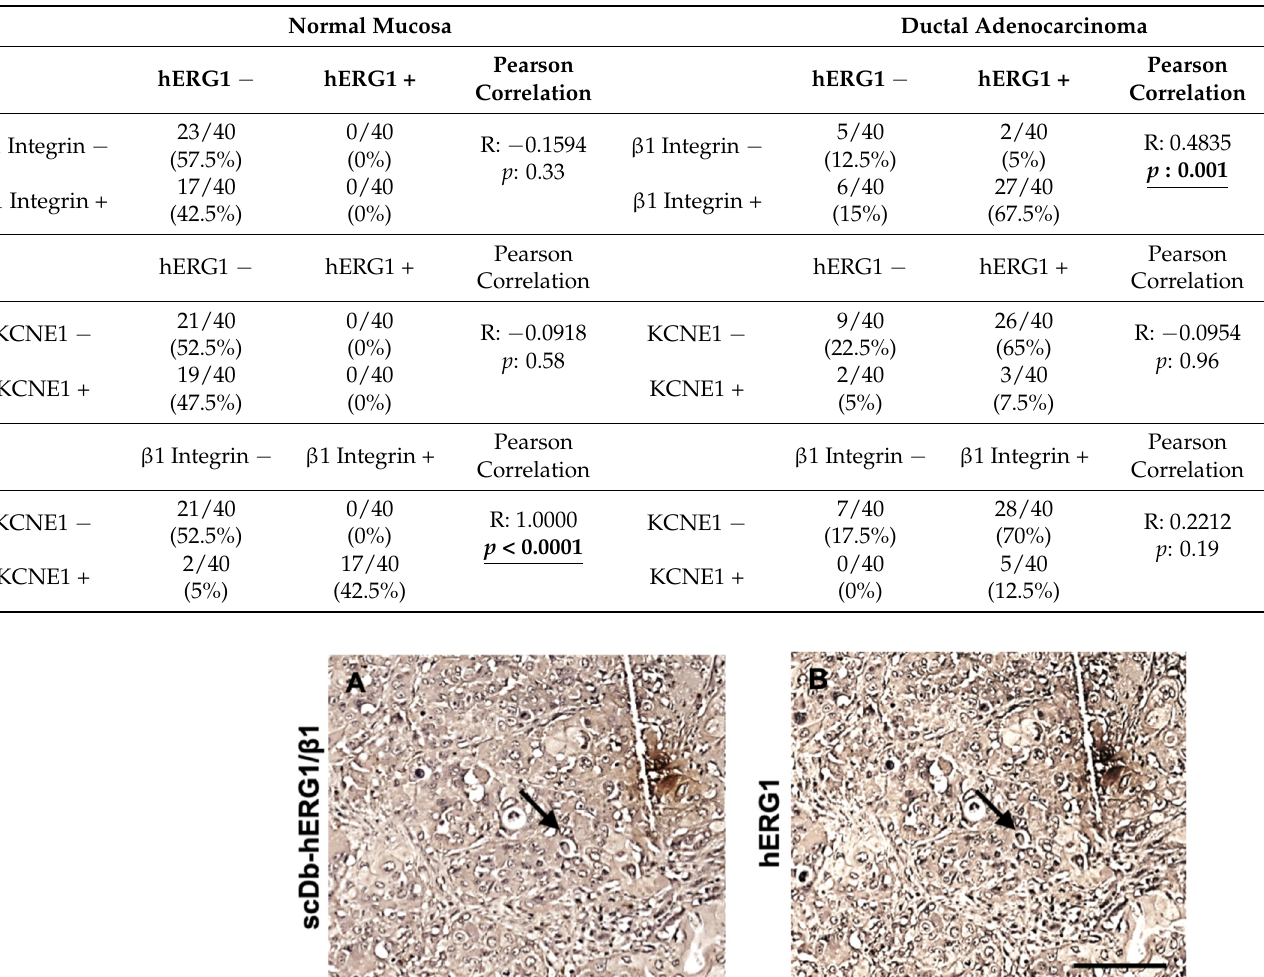
8 of 20 (left panel) and densiometric analysis (right panel) are reported ( n = 3). ( D ) Representative blots and corresponding densitometric analysis of the co-immunoprecipitation between hERG1 and β 1 integrin (performed using TS2/16) in normal and PDAC samples. Data are presented as mean values